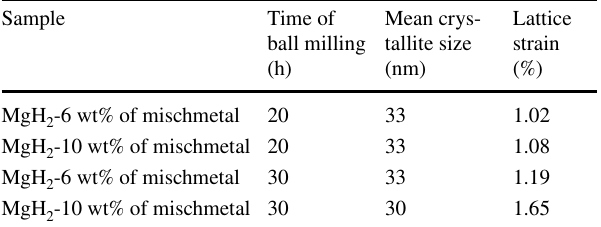
Table 2 confirms the role of adding catalyst in creating lat- tice strain in crystallites in comparison with MgH